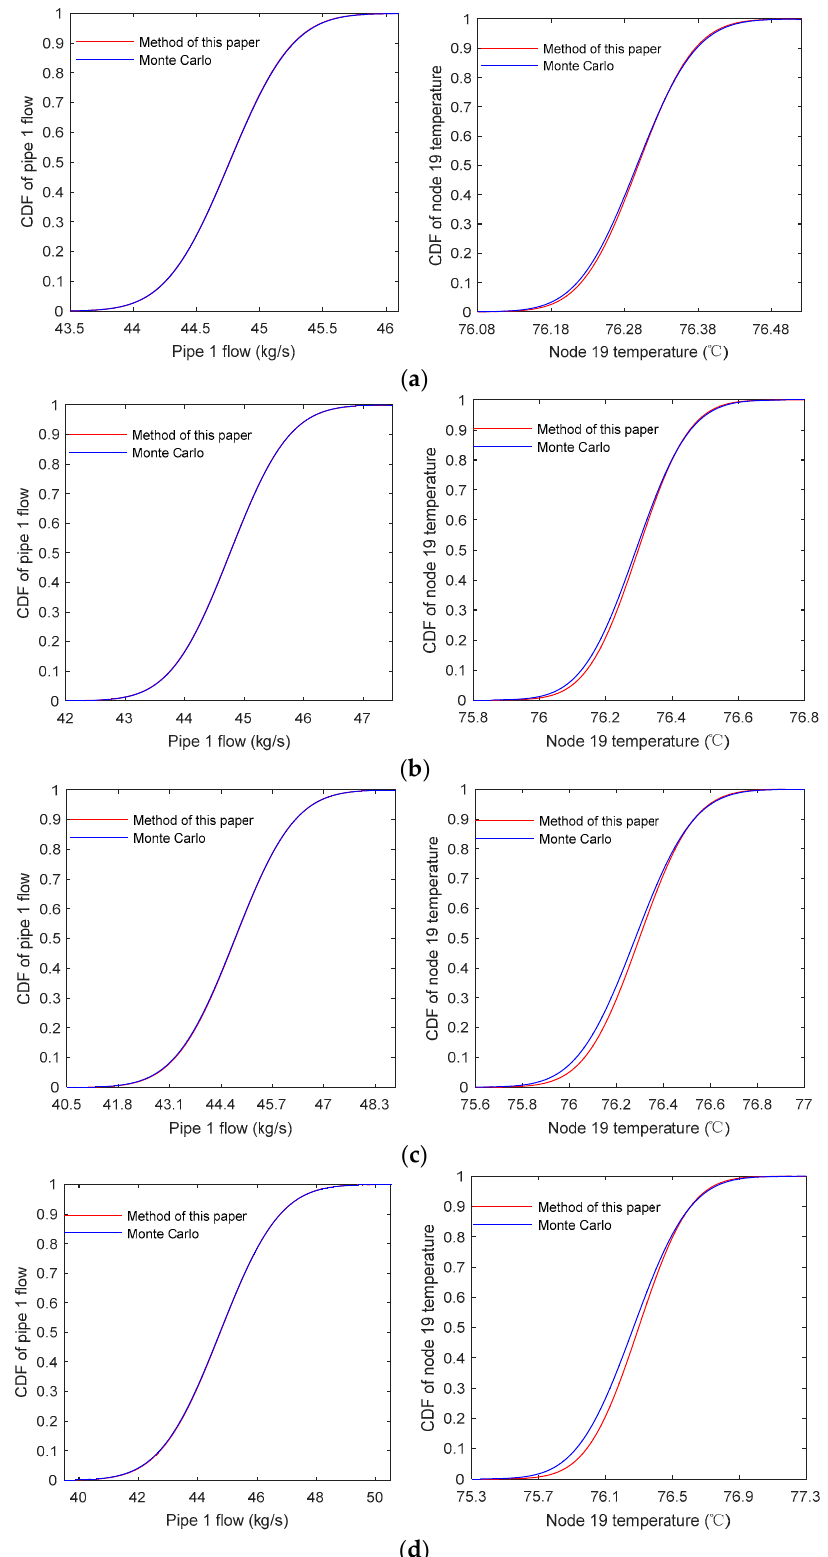
Figure 4. Cumulative density functions (CDFs) of mass flow rate through pipe 1 and node 19 temperature (Test 2: L = 1500 m; μ ϕ = 0.5 MW) under different thermal load fluctuations: (a) within ±10%; (b) within ±20%; (c) within ±30%; and (d) within ±40%.